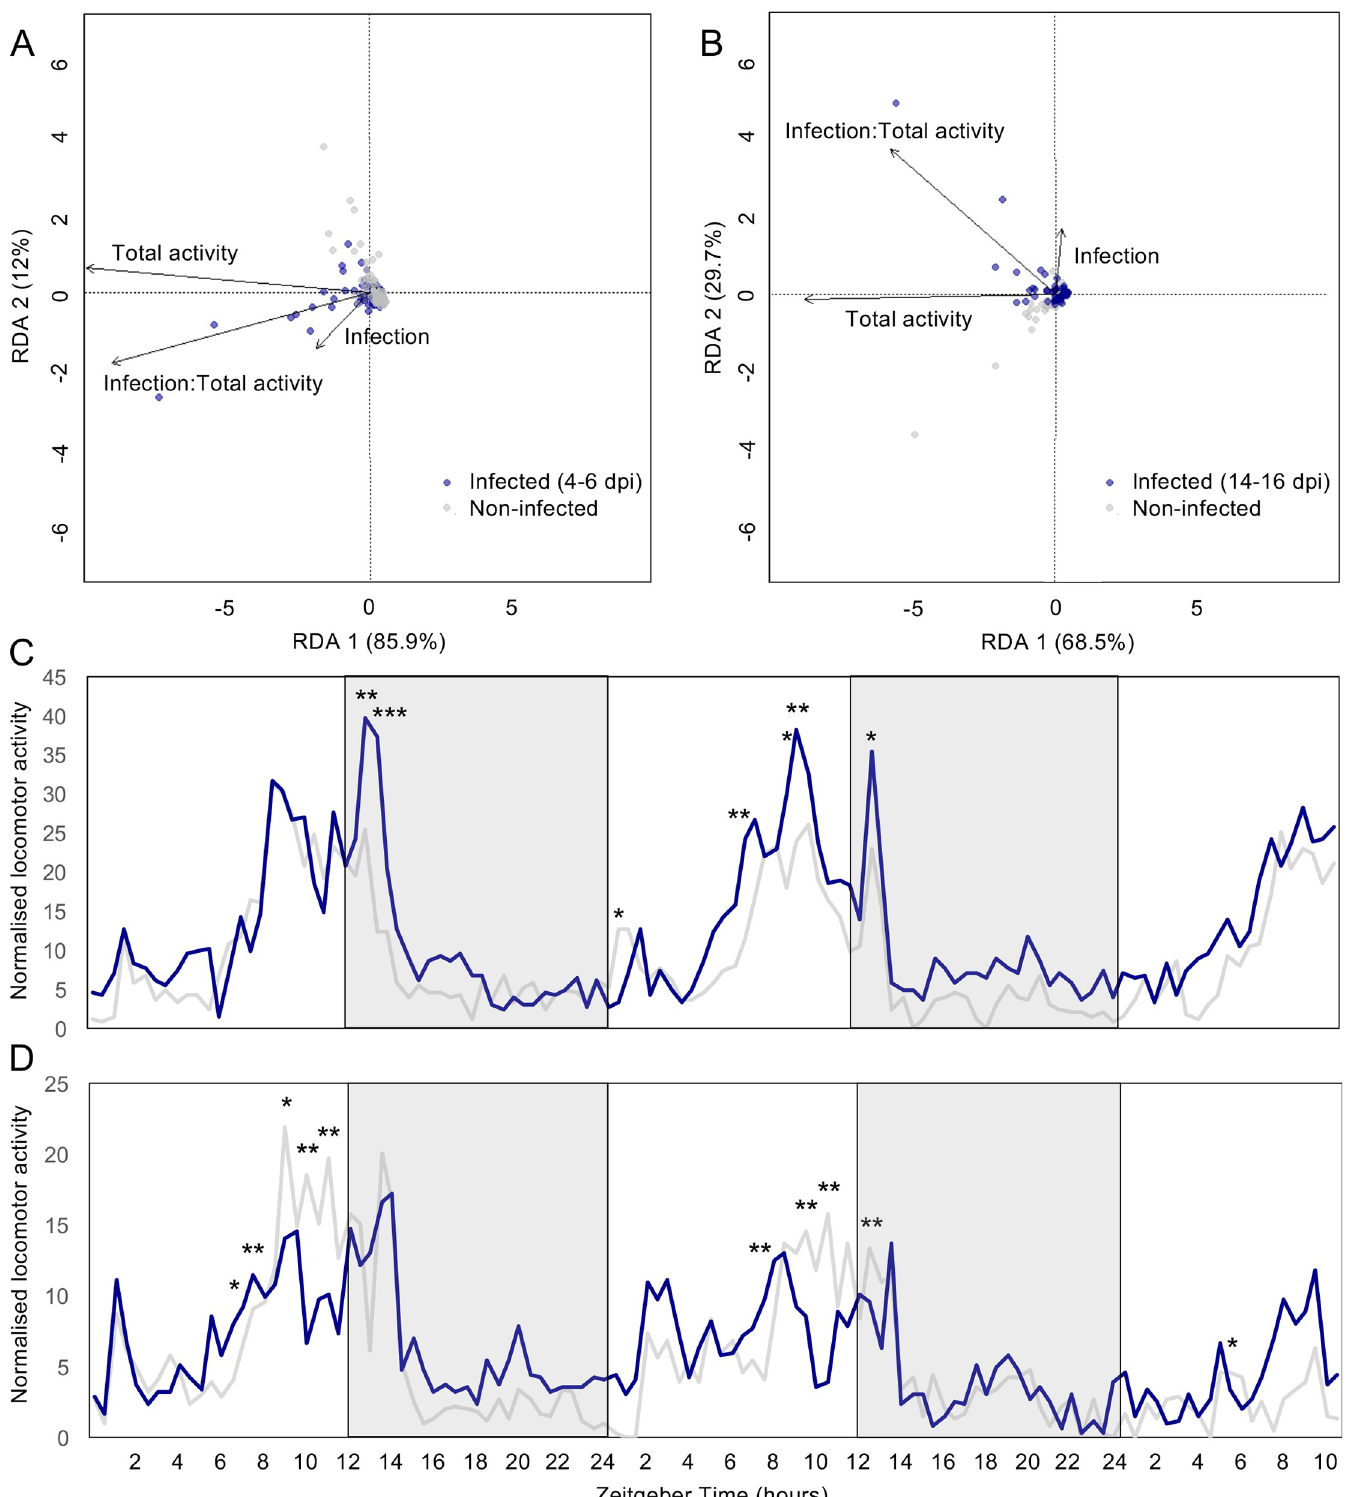
Fig 1. Dengue infection differentially affects locomotor activity. Individual locomotor profiles (n = 317) were assessed for variation using a redundancy analysis, revealing an effect of DENV-1 in 4.5–6 days post-infection (dpi) A) but not 14.5–16 dpi; B) female Ae . aegypti . Each dot represents the observed activity profile for each individual mosquito throughout the experiment. The position within the ordination is determined by the pairwise Euclidean distance among all the objects in the